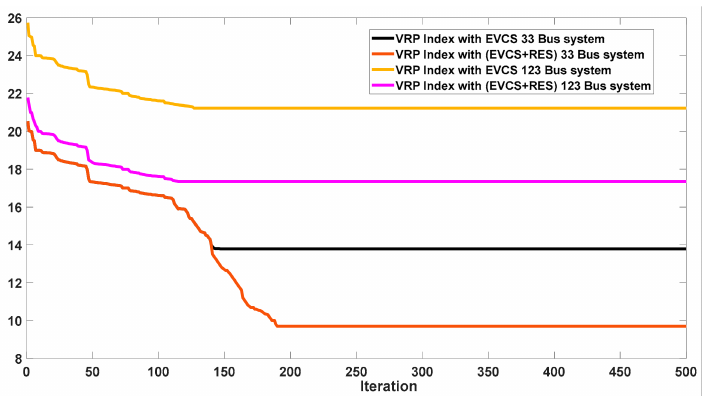
Figure 19. Convergence characteristics comparison of the proposed case on selected test systems.